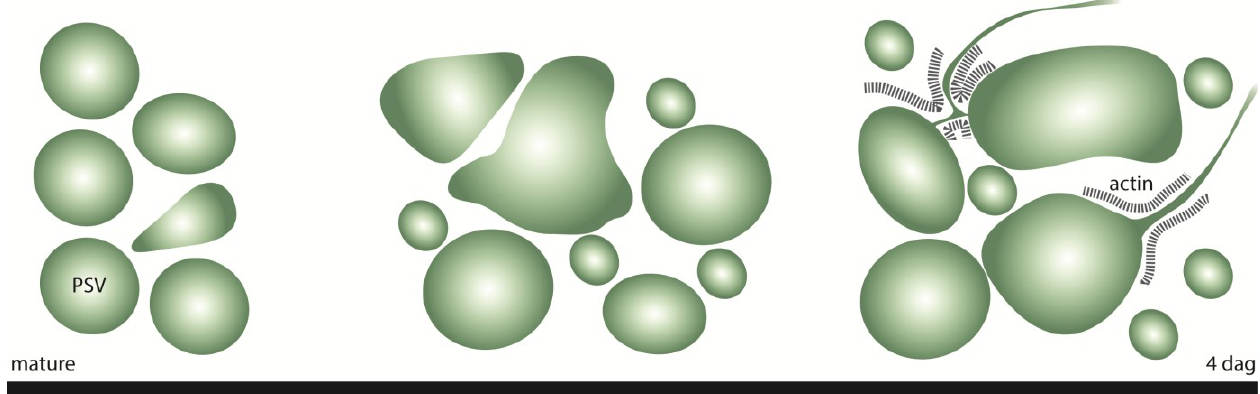
Figure 5. Schematic summary of the morphological changes of the PSVs and the formation of PSV tubules in barley aleurone cells during germination. dag = days after